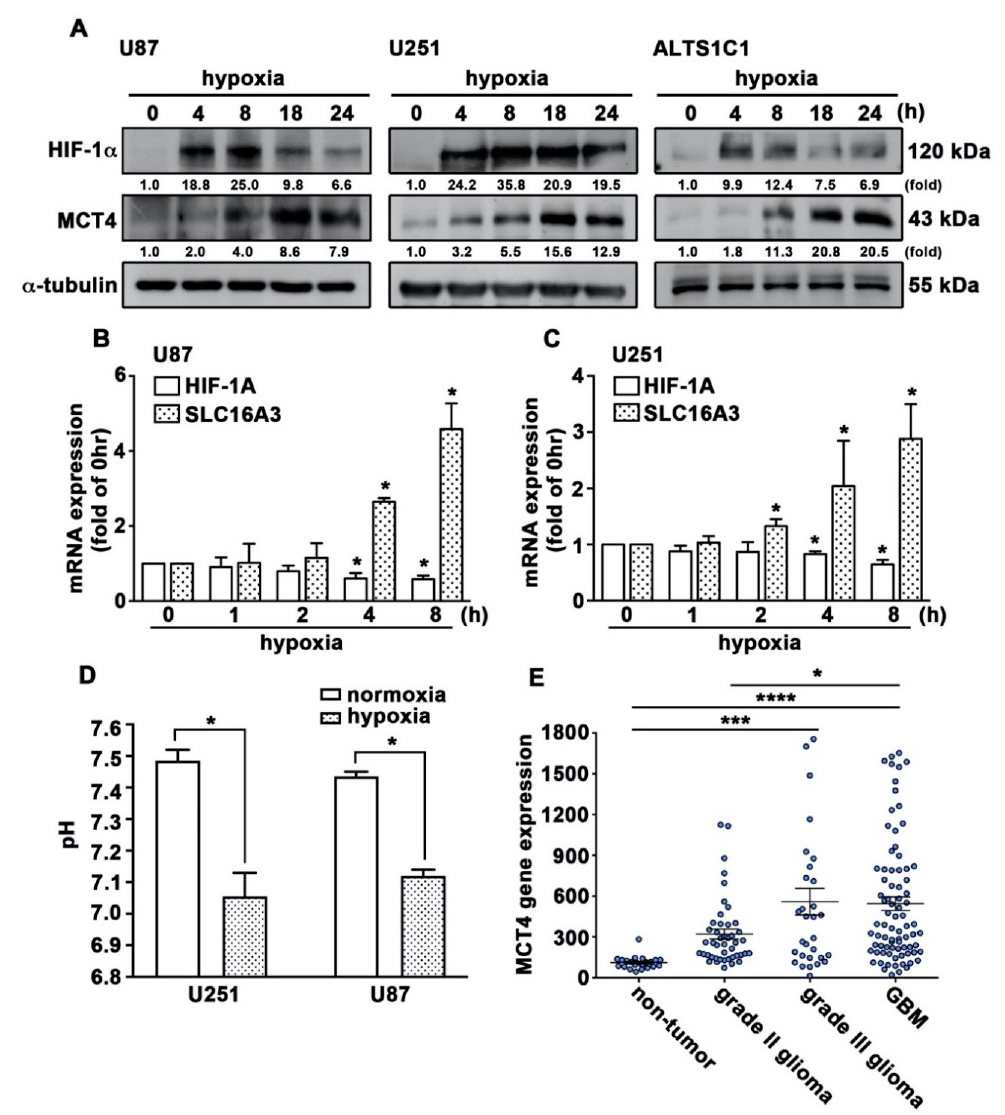
Figure 1. Hypoxia induces HIF-1 α and MCT4 expression in GBM. ( A ) Human GBM cell lines U87 and U251 and the mouse GBM cell line ALTS1C1 were exposed to hypoxic conditions (1% O 2 ) for indicated time periods (4, 8, 18, or 24 h). HIF-1 α and MCT4 protein expressions were determined using western blotting. U87 ( B ) and U251 ( C ) were exposed to hypoxic conditions (1% O 2 ) for indicated time periods (1, 2, 4, or 8 h), and HIF-1 α , and MCT4 mRNA expression was determined by qPCR. One-way ANOVA with a post-hoc Bonferroni test was used to examine the significance of the mean. * p < 0.05 compared with the control group. Quantitative data are presented as the mean ± S.E.M. ( n = 3). ( D ) pH measurements of culture medium 24 h after growing GBM cells under hypoxic conditions (1% O 2 ). * p < 0.05 compared with the normoxia group (Student’s t -test). Quantitative data are presented as the mean ± S.E.M. ( n = 3). ( E ) mRNA levels of MCT4 in patients’ specimens from the human glioma microarray dataset GSE4290. One-way ANOVA with a post-hoc Bonferroni test was used to examine the significance of the mean. * p < 0.05 GBM compared with grade II glioma. *** p < 0.001 grade III glioma compared with non-tumor. **** p < 0.0001 GBM compared with non-tumor.